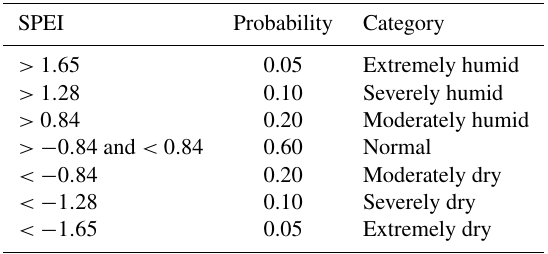
Table 1. SPEI classification according to Agnew